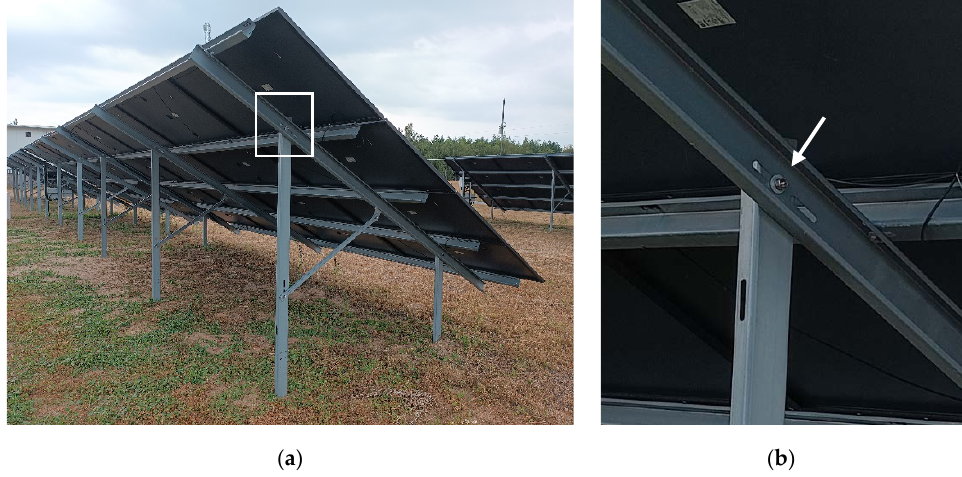
Figure 1. ( a ) An example of a substructure for photovoltaic panels made of thin-walled cross-sections with typical bolt connectors; ( b ) magnified bolt connector with a nut (source: grant POIR.01.01.01-00-0177/21).